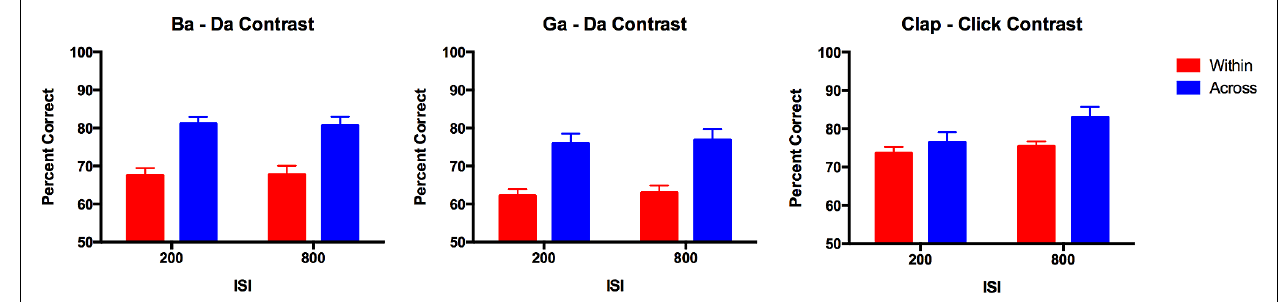
FIGURE 4 | Pre-stimulation discrimination accuracy for across and within-category stimuli. Bars represent the group mean ( n = 23); error bars represent the SE of the mean.The three contrasts each showed the typical